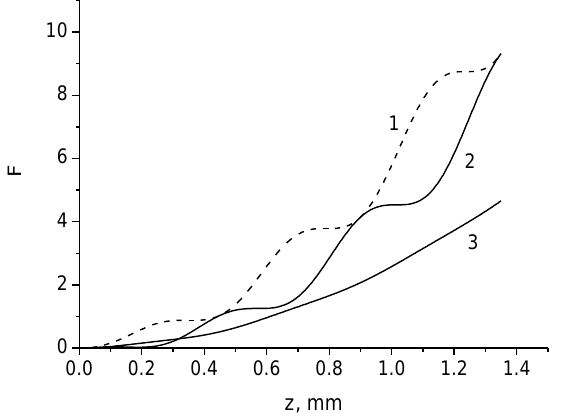
(cid:0) (cid:1) Figure 4. The values F = 10 5 as a function of distance for x 0 = 15 µ m; curve 1—sagittal 4det J / Sp 2 J ( ) 5 2 ray with positive helicity ( p y 0 = x 0 ω ); curve 2—sagittal ray with negative helicity ( p y 0 = − x 0 ω ); 10 4 det / F J Sp J = as a function of distance for x 0 = 15 μ m; curve Figure 4. The values curve 3—meridional p x = ); curve 2 — sagittal ray with negative helicity 1 — sagittal ray with positive helicity ( 0 0 y ( x = − ); curve 3 — meridional ray.